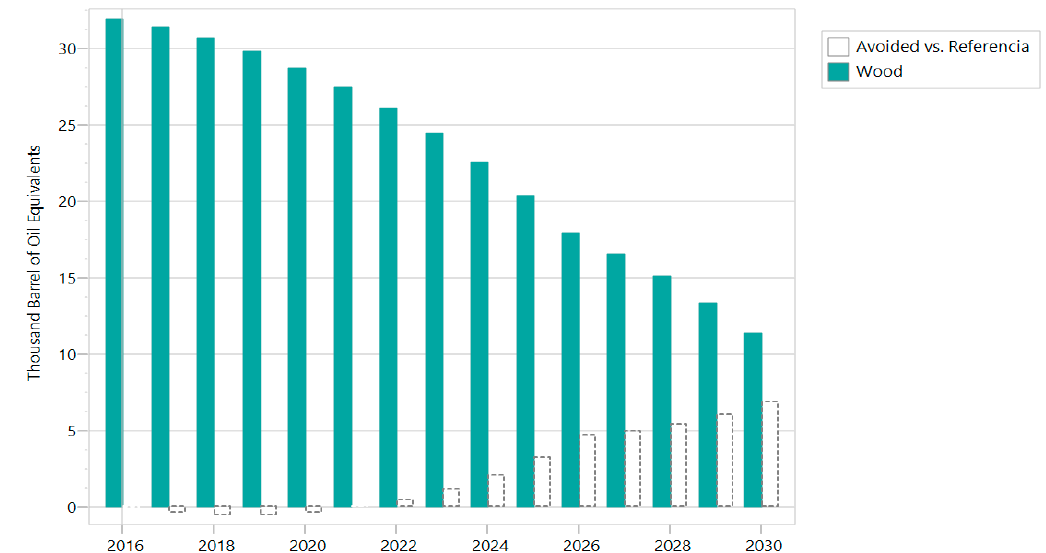
Figure 14. Firewood demand in commercial sector vs. what would be avoided according to BAU scenario.